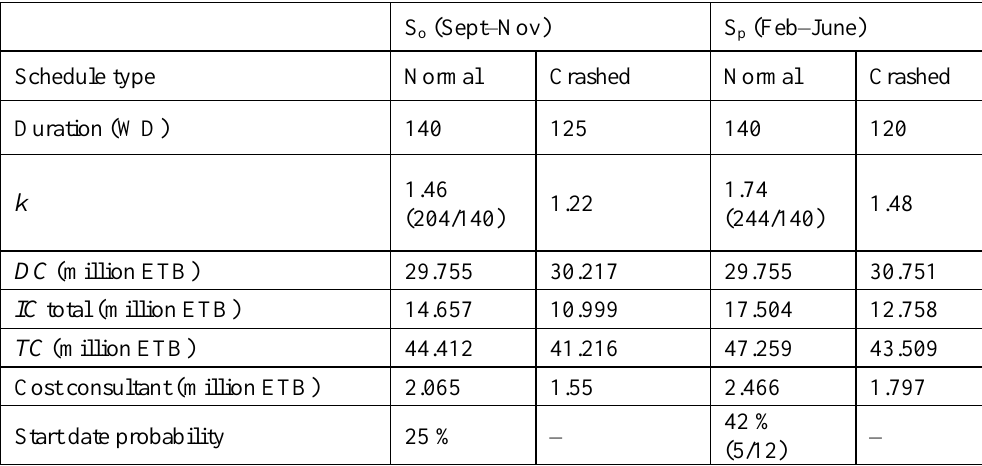
Table 2. Optimal Value of Cost and Schedule for the Worst